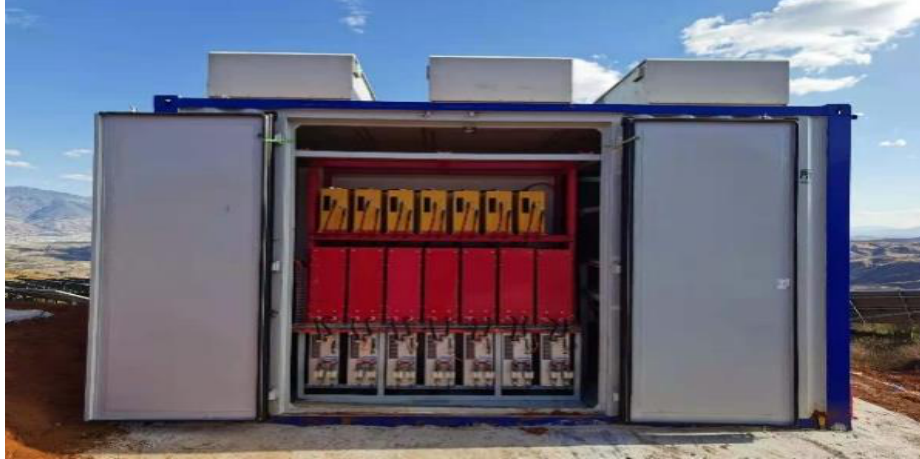
Figure 25. The inside of the ±30 kV/1 MW DC/DC converter engineering prototype.